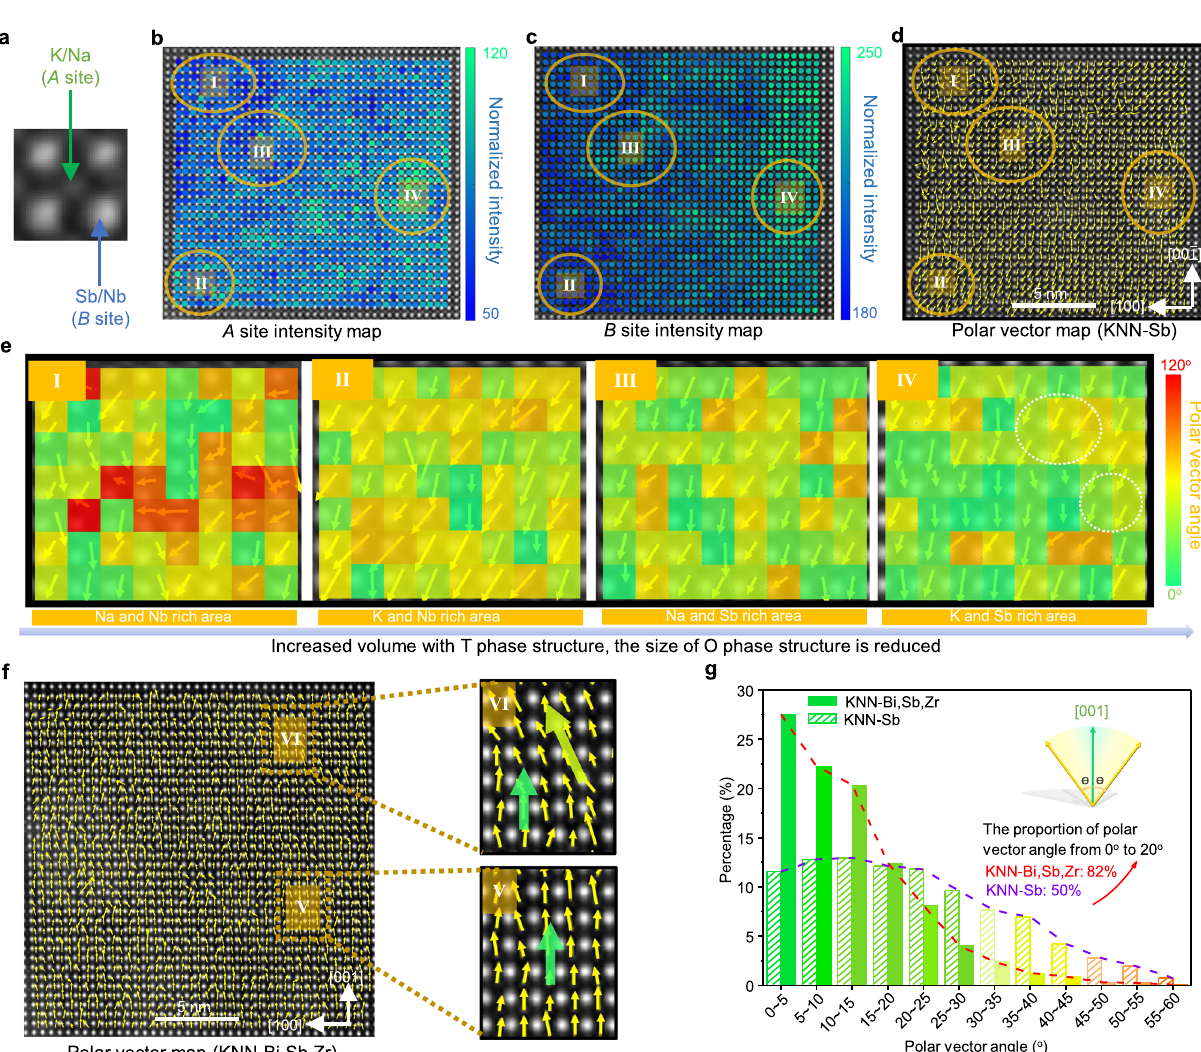
Fig. 3 The relationship of dopant, average structure, and local structure in KNN-based materials. a A unit cell showing the atomic site occupation for KNN-Sb ceramic. b Normalized intensity of the A site for the KNN-Sb ceramic. Areas with high A site intensity are K rich. c Normalized intensity of the B site for the KNN-Sb ceramic. Areas with high B site intensity are Sb rich. d Polar vector map for KNN-Sb ceramic, the polar vectors (arrows) are given for each unit cell column. A unit cell with the polar vector direction along the [001] direction is of the T structure, and along the diagonal direction is of the O structure. e The enlarged areas of Na/Nb, K/Nb, Na/Sb, and K/Sb rich in ( d ). The different colour of unit cells shows the angle of polar vector direction off the [001] direction. f Polar vector map for KNN-Bi,Sb,Zr ceramic. The enlarged areas show the local average polar vector directions are slightly off the [001] direction (area VI) and along the [001] direction (area V), respectively. g The statistic percentage of polar vectors as a function of the polar vector angle (i.e., the de fl ection angle of polar vector off the [001] direction), based on ( d , f the low-angle polar vectors (light yellow and light blue areas in Fig. 3e – g. Fig. 4b at 0 kV/cm) and nearby structure change substantially with an increase in the external electric fi eld. In contrast, the local structures with large-angle polar vectors (i.e., the de fl ec- tion angle deviating from the tetragonal spontaneous polar- ization direction [001] is >20°) under the external electric fi eld change much smaller (the orange frame regions in Fig. 4a) when compared to the local structures with low-angle polar vectors, revealing the polar vectors with large-angles response weakly to the external electric fi eld. These different responses to the external electric fi elds between the local structures with large- and low-angle polar vectors result from the competition between the Landau energy barrier and the interfacial energies. The interfacial energies, including electrostatic, elastic, and gradient energies, are generated due to the discontinuity of the polarization and strain 28 .